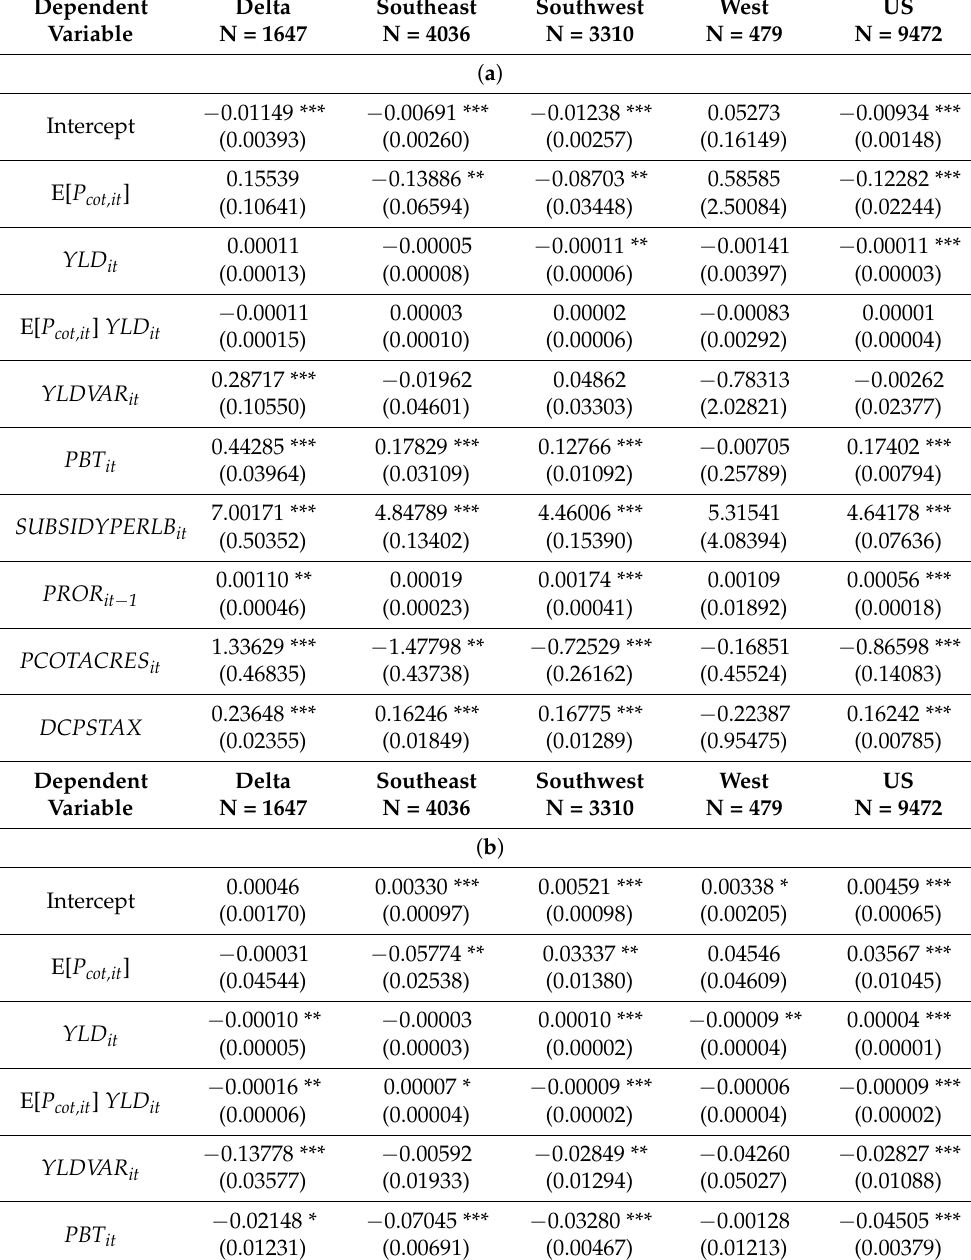
Table 2. (a) Parameter estimates of simultaneous equations: percent insurance participation. (b) Pa- rameter estimates of simultaneous equations: percent cotton